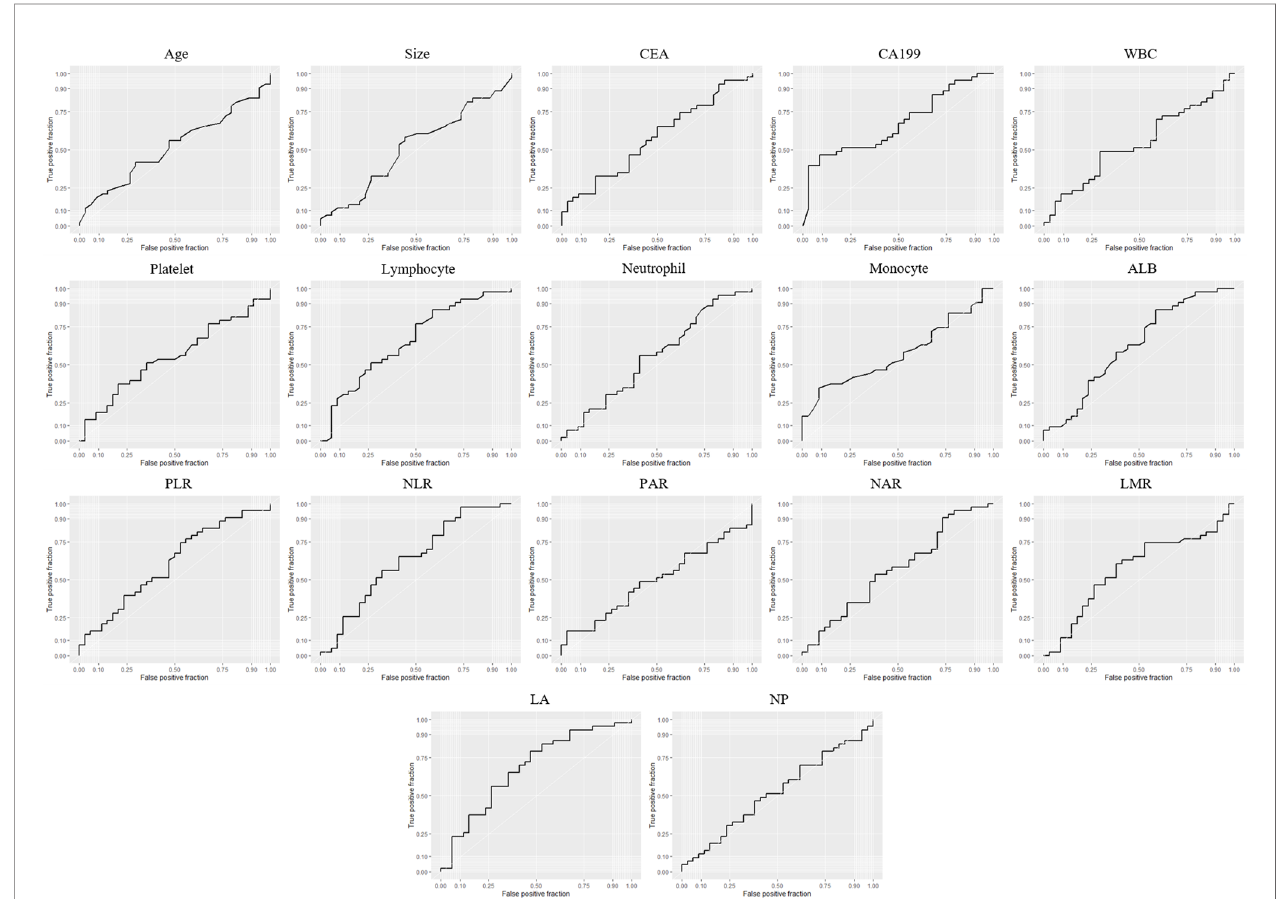
FIGURE 1 | ROC curve of the preoperative indices for differential diagnosis of SCNs and MCNs. PLR, platelet – lymphocyte ratio; NLR, neutrophil – lymphocyte ratio; PAR, platelet – ALB ratio; NAR, neutrophil – ALB ratio; LMR, lymphocyte – monocyte ratio; LA, lymphocyte × ALB; NP, neutrophil ×